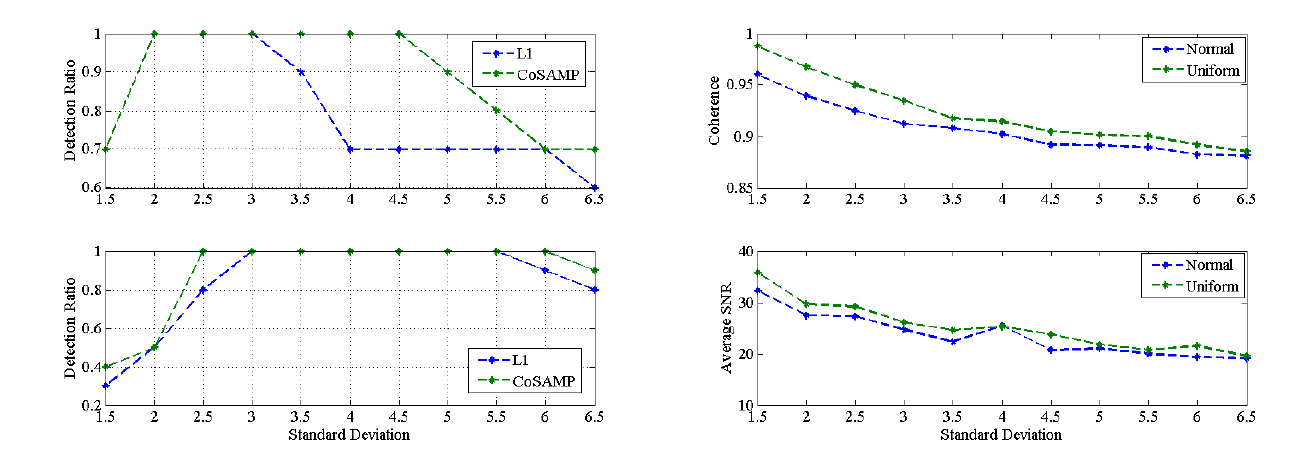
Figure 4. (a) Detection ratio for normal distribution (b) detection ratio for uniform distribution